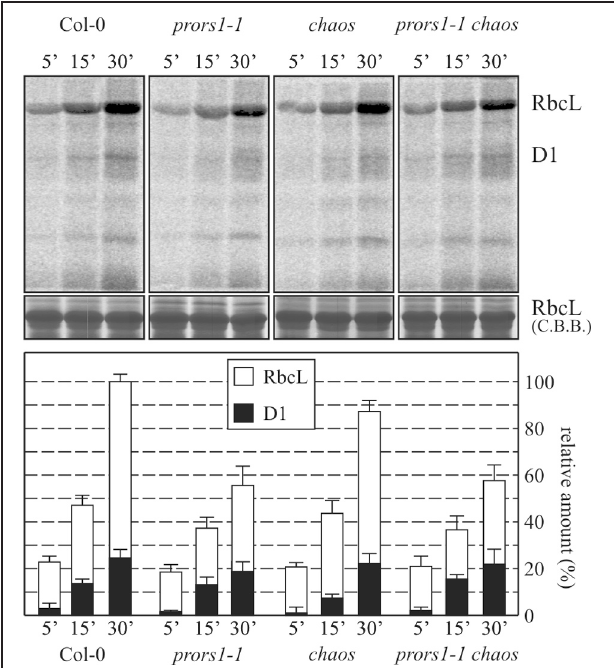
FIGURE 4 | Translational efficiency of chloroplast-encoded mRNAs in WT (Col-0) and mutant ( prors1-1 , chaos, and prors1-1 chaos ) leaves. Leaves isolated from 6-leaf-rosette plants were pulse-labeled with [ 35 S]methionine under low-level illumination (20 μ mol photons m − 2 s − 1 ) for 5, 15, and 30min in the presence of cycloheximide to inhibit cytosolic protein synthesis. Total leaf proteins were then isolated, fractionated by SDS-PAGE, and detected by autoradiography. A portion of the Coomassie Brilliant Blue (CBB)-stained gel, corresponding to the RbcL migration region, was employed as internal standard for data normalization. Levels of [ 35 S]methionine incorporation into RbcL and D1 proteins were quantified and are shown in the histogram. Values are averages of 5 independent experiments and were normalized to the maximal signal intensities obtained in WT leaves after 30min